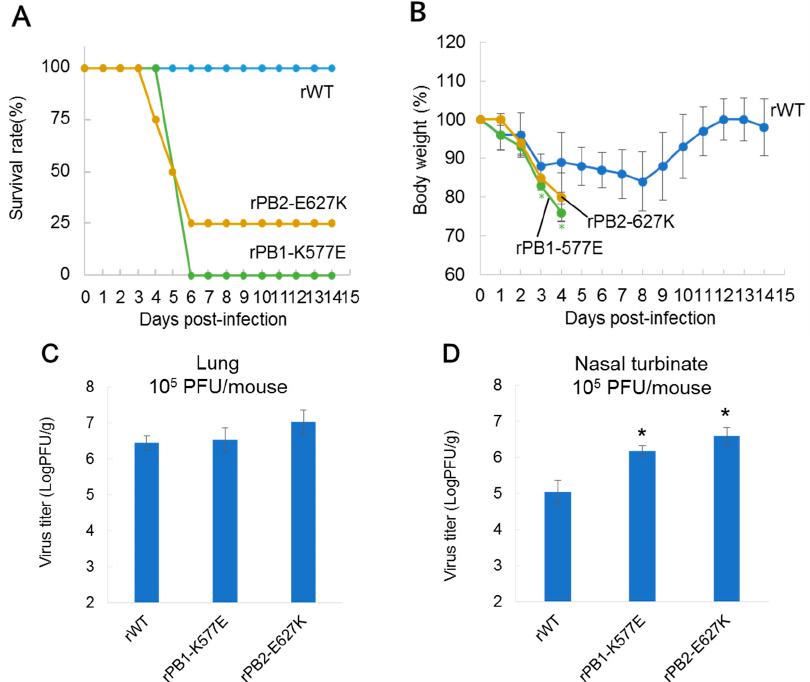
Figure 1. Pathogenicity of polymerase mutant viruses in mice. Six-week-old female BALB/c mice ( n = 4 per group) were inoculated intranasally with 10 5 plaque-forming units (PFU) of wild-type (rWT) or mutant (rPB1-K577E or rPB2-E627K) virus per mouse. ( A ) Mortality and ( B ) body weight changes of virus-inoculated mice were assessed for 14 days. Mice that showed a more than 25% body weight loss were euthanized and scored. Significant body weight changes of the mutant virus-infected mice compared with rWT-inoculated mice ( p < 0.05, Student’s t -test, two-tailed analysis) are indicated by an asterisk (*). Replication of rWT, rPB1-K577E, and rPB2-E627K in the ( C ) lungs and ( D ) nasal turbinates of the mice ( n = 4 per group) at 3 days post-infection. Virus titers (PFU/g) were determined by plaque assay in Madin-Darby canine kidney (MDCK) cells and were presented as mean PFU/g ± standard deviation (SD). Viruses with significant growth enhancement compared the rWT ( p < 0.05, Student’s t -test, two-tailed analysis) are indicated by an asterisk (*).